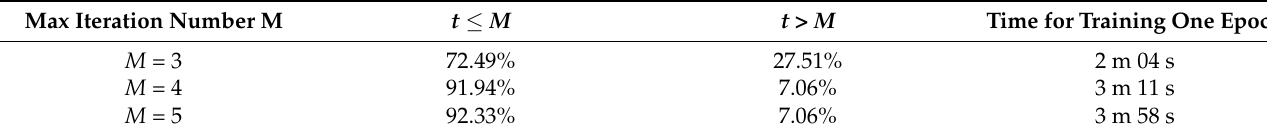
Table 6. Details of different maximum